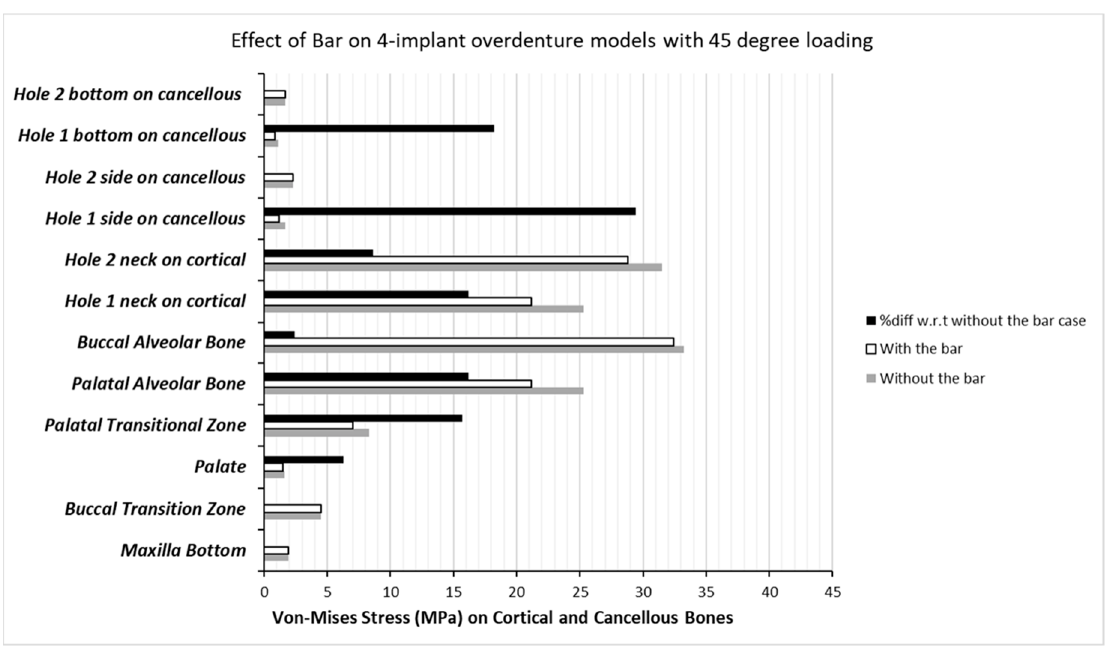
Figure 8. Effect of bar on three-implant overdenture models with 45-degree loading.